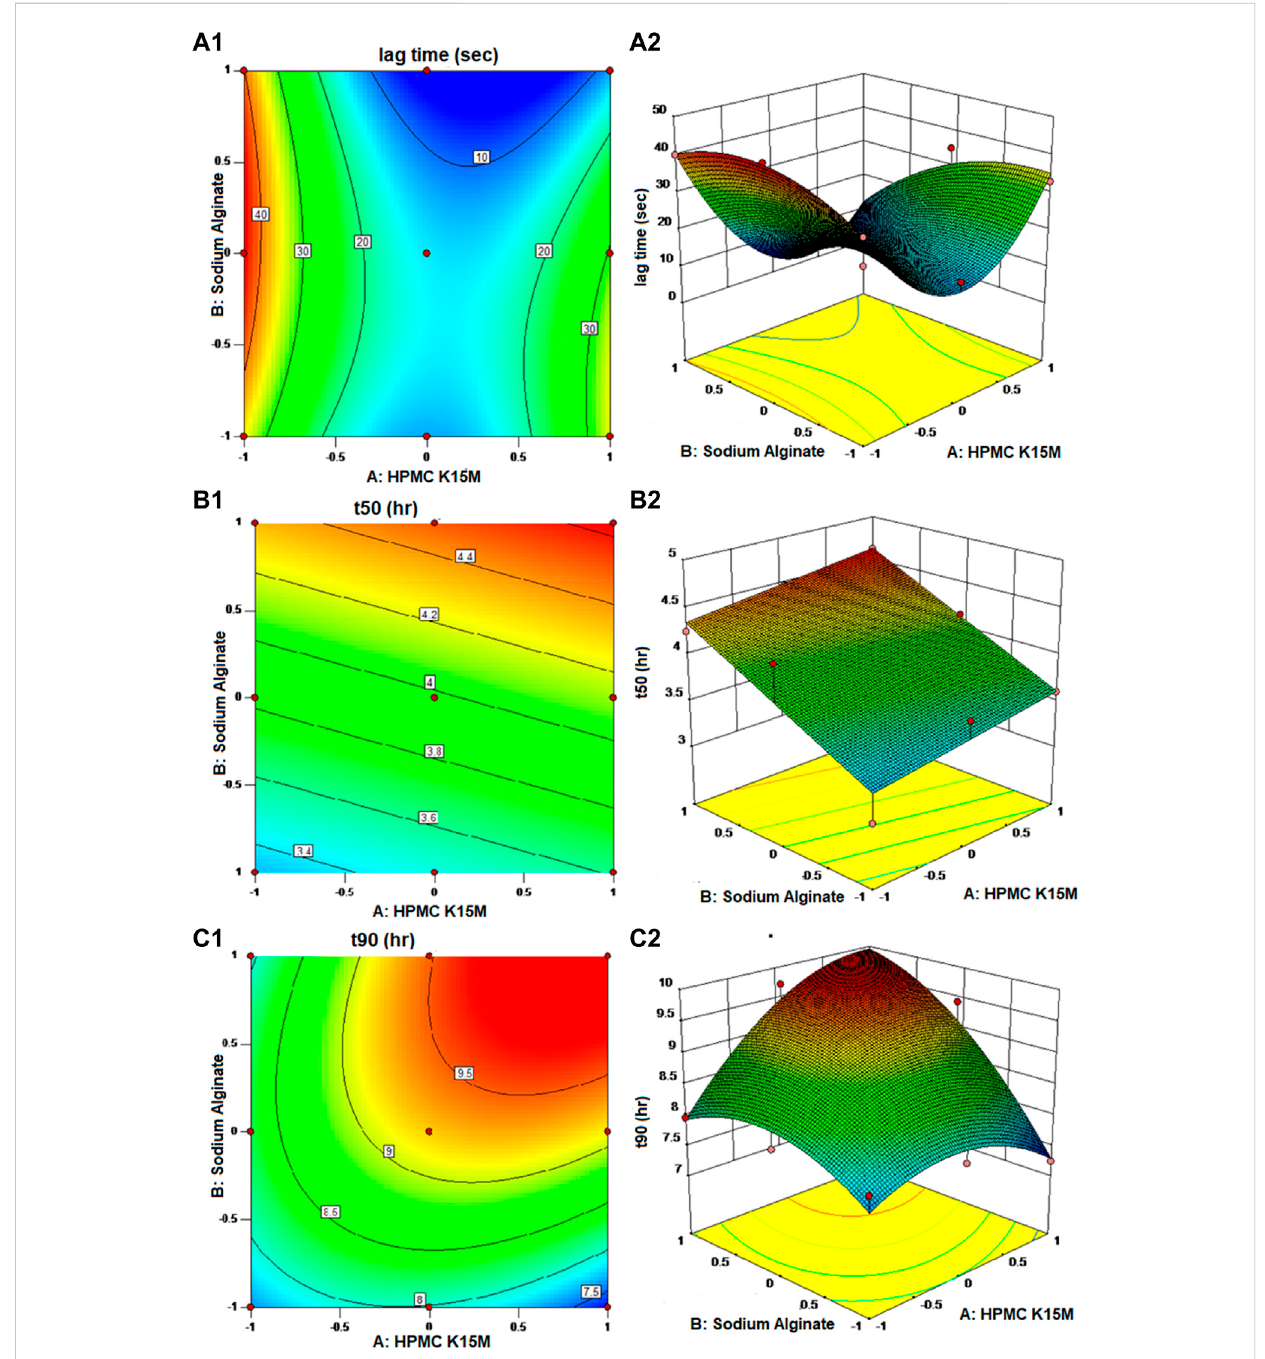
FIGURE 3 Contour plot and response surface plot: (A1, A2) lag time, (B1, B2) time to release 50% of the drug, and (C1, C2) time to release 90% of the drug.